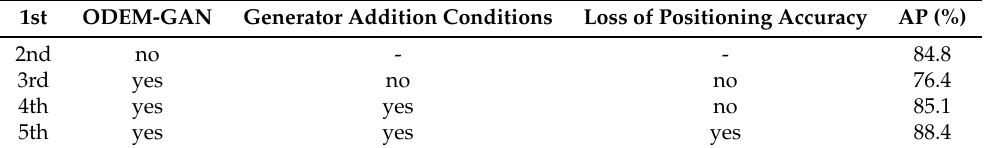
Table 4. ODEM-GAN ablation experiment